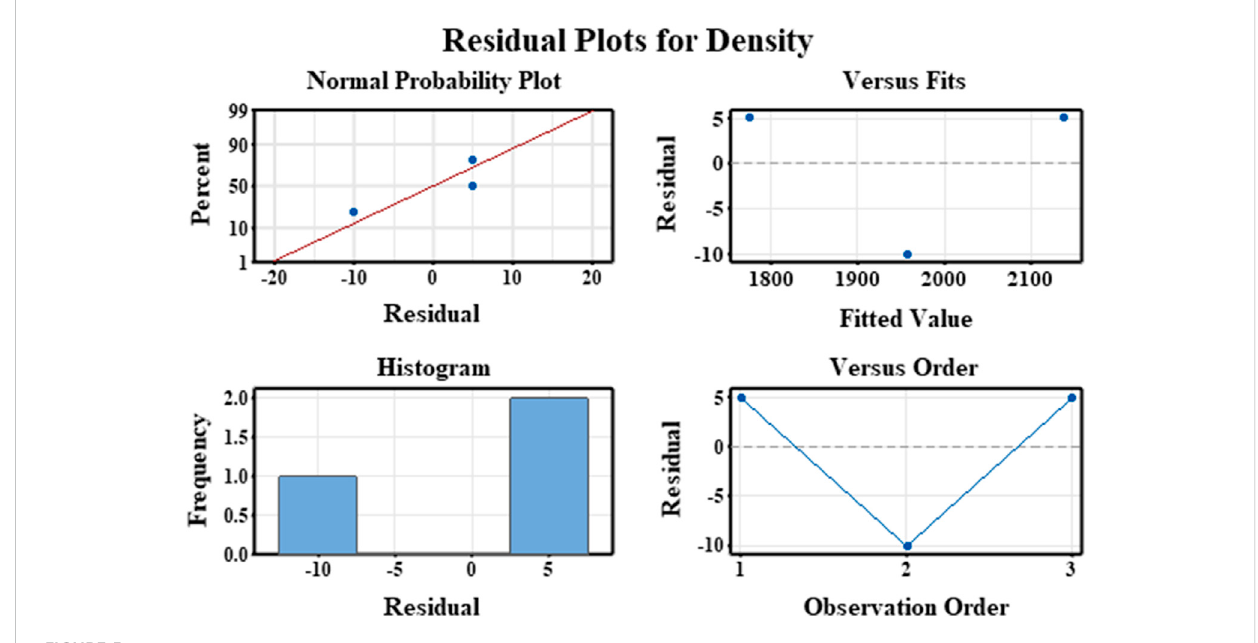
FIGURE 5 Residual plots for density.